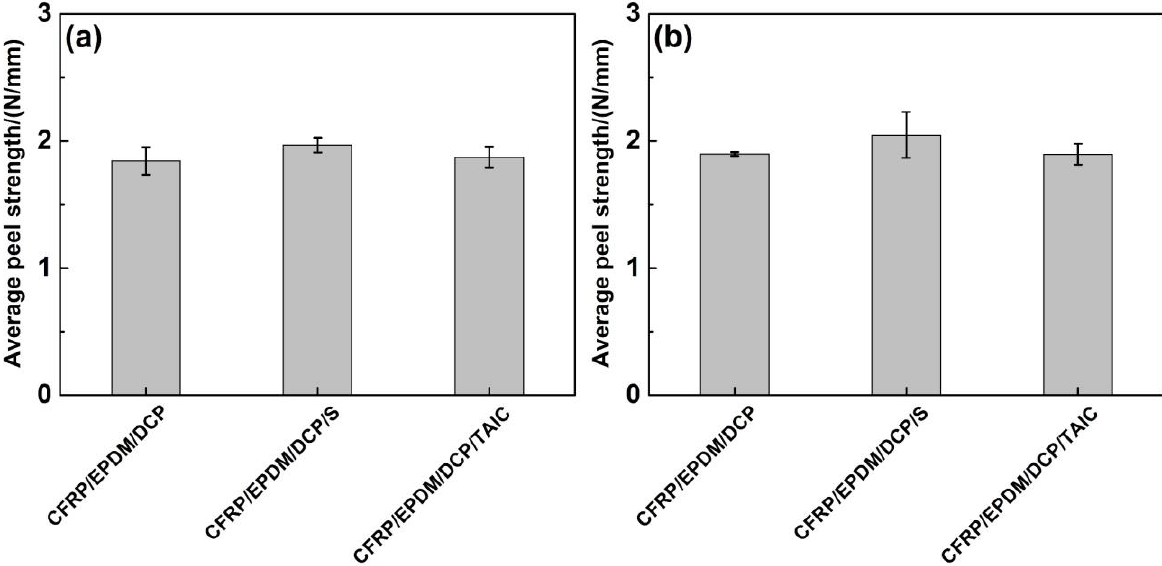
Figure 4. The average peel strength of CFRP/EPDM composites. ( a ) 160 °C, 1 h. ( b ) 170 °C, 1 h.